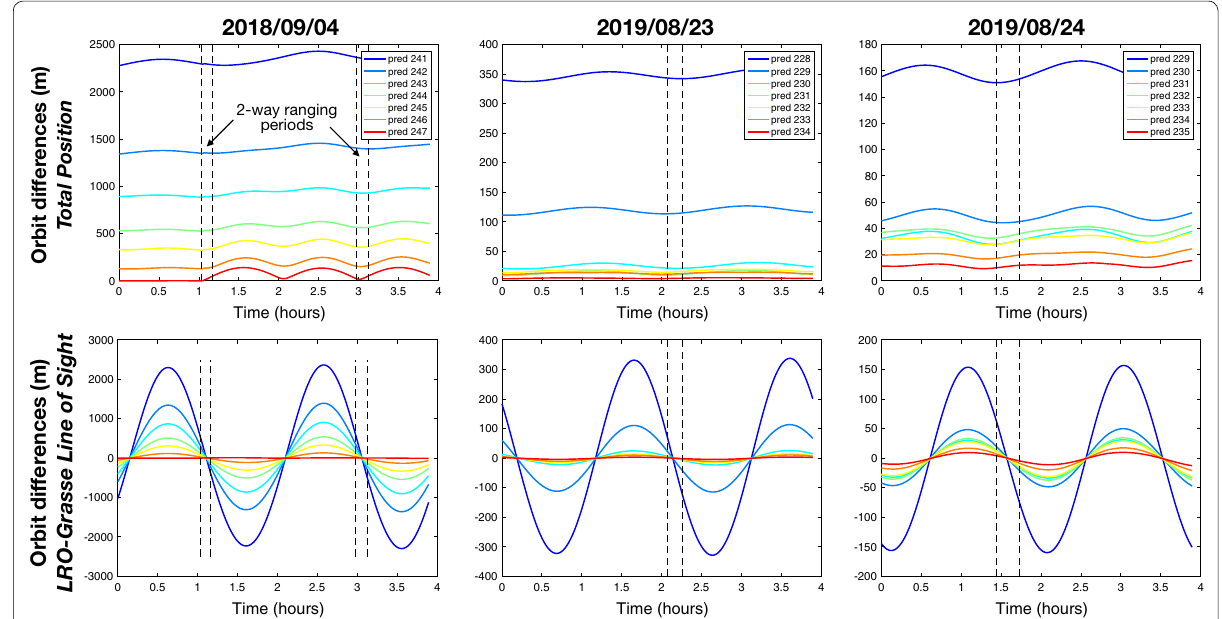
Fig. 6 Evolution of errors of daily orbit prediction project deliveries. These were assessed as the difference with the reconstructed orbit. Total position (dominated by the along‑track component) and Grasse‑LRO line‑of‑sight (LoS) discrepancies are shown. The periods where the two‑way laser ranging was performed are indicated with vertical dashed black